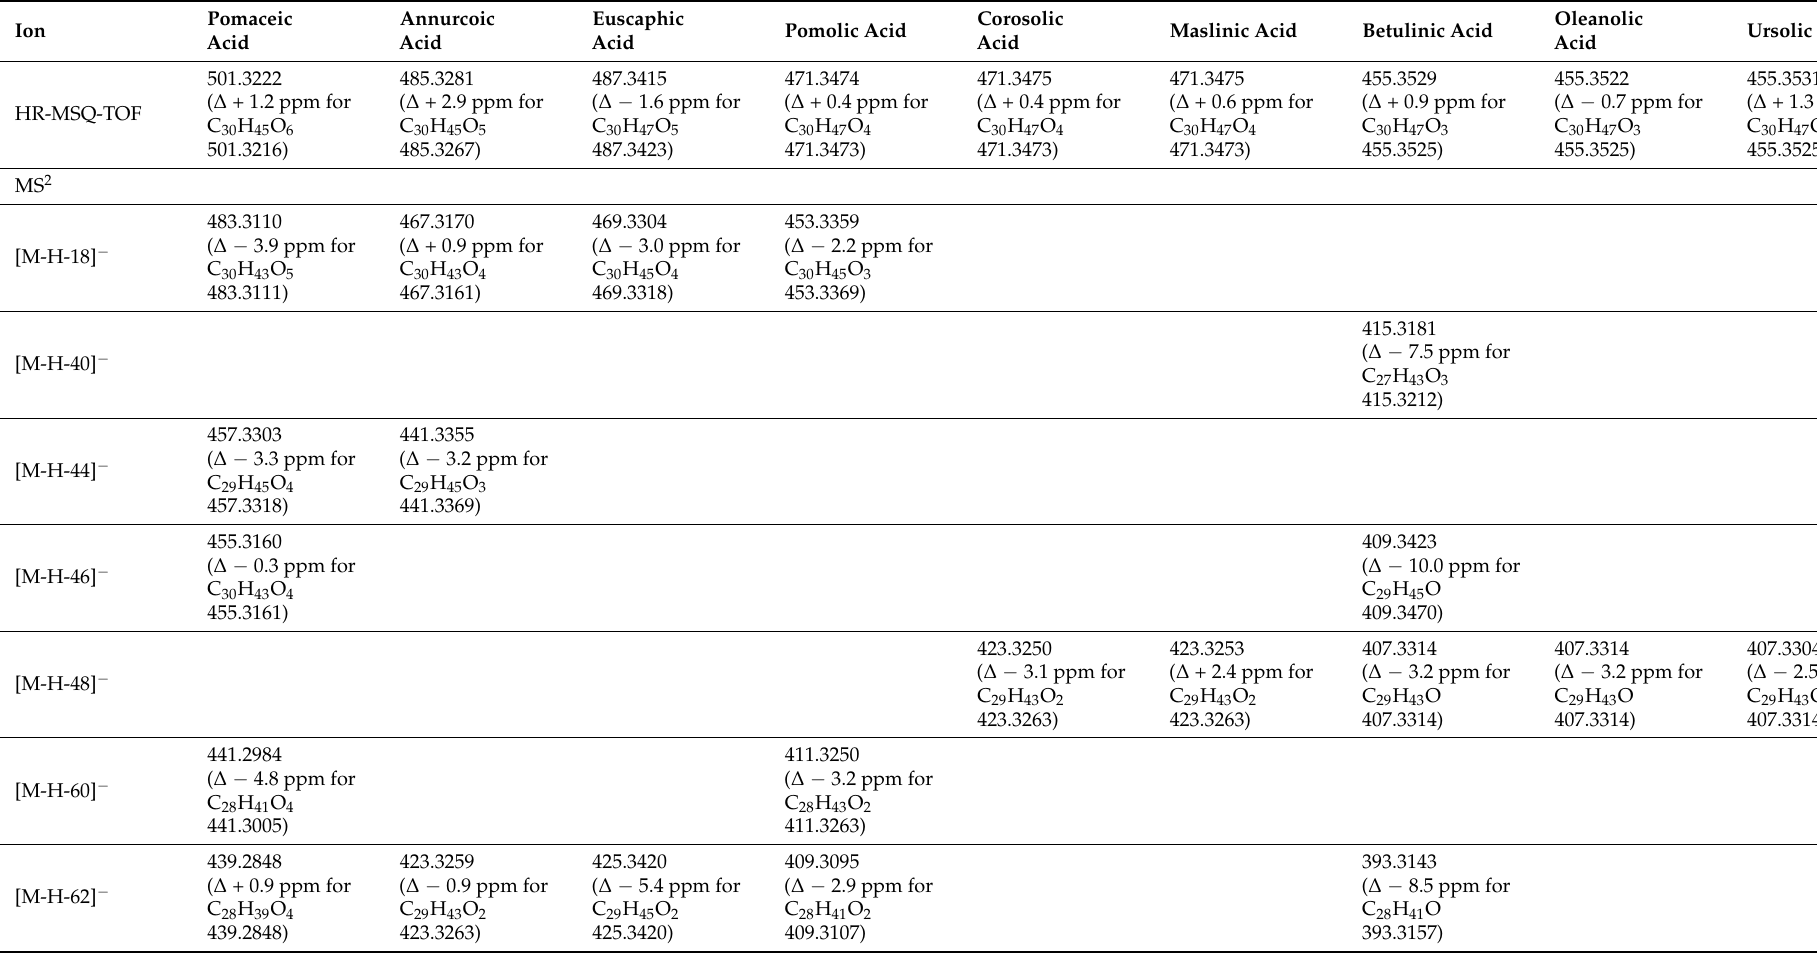
Table 6. Main fragments observed for the considered apple triterpene acids, low-resolution species were detected in ion trap (LR-IT), while high-resolution species were detected using Q-TOF (HR-Q-TOF). Reproduced with the permission of John Wiley and Sons